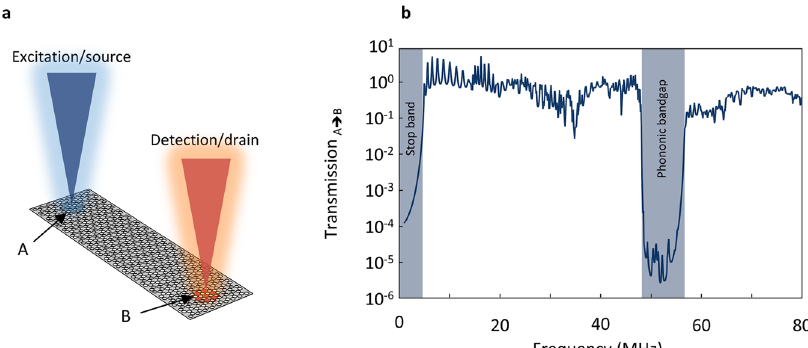
Fig. 2 Probing the band structure via transmission studies in a fi nite-size phononic crystal. a Transmission geometry for a rectangular phononic device. At point A mechanical motion is excited by a frequency modulated laser (blue). The vibrational wave travels through the device and is detected at point B by a second laser spot (red). b Transmission from A to B vs. excitation frequency for the device shown in a . A clear bandgap region is visible (blue shaded) where transmission of mechanical motion through the device is suppressed by ~10 5